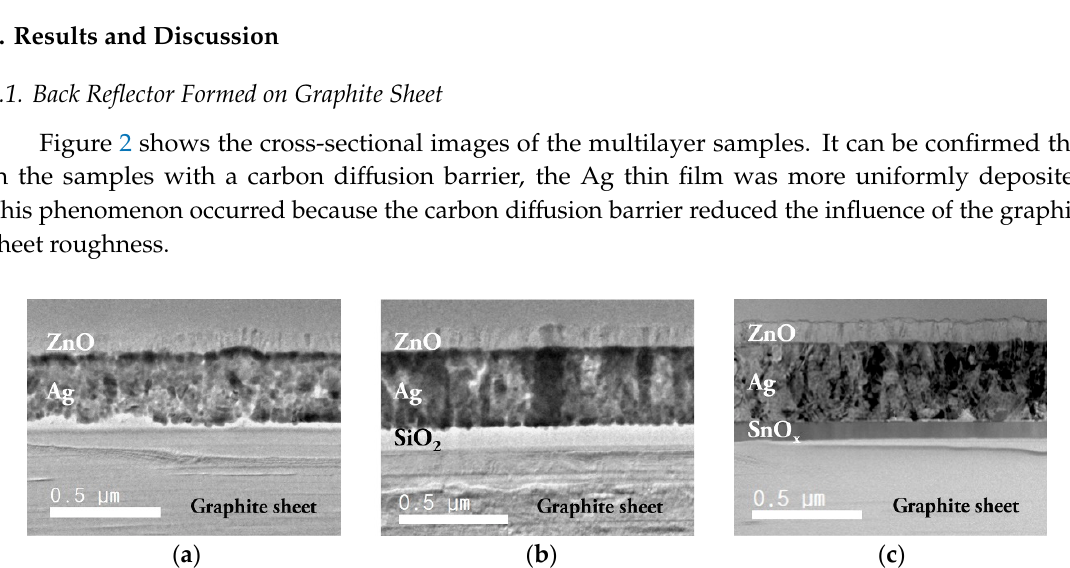
Figure 1. Structure of solar cells using graphite sheet: ( a ) without barrier layer, ( b ) with silicon oxide (SiO 2 ) barrier layer and ( c ) with tin oxide (SnO x ) barrier layer.